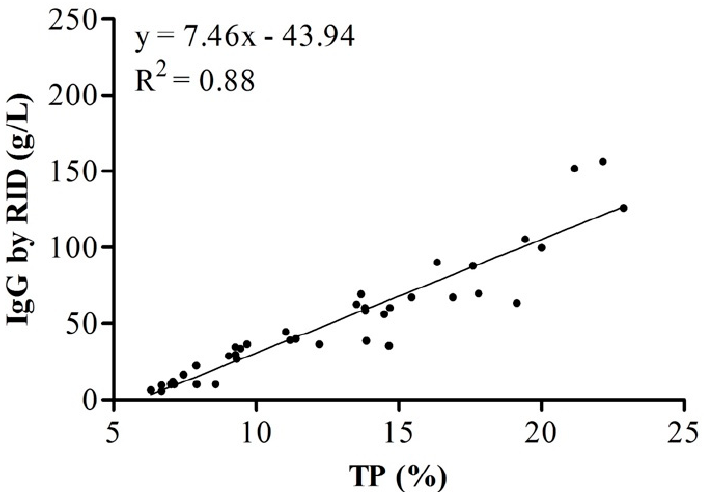
Figure 3. Relationship between total protein (TP) and immunoglobulin G (IgG) in ovine colostrum. IgG was measured by radial immunodiffusion, and total protein was measured by MilkoScan FT + .